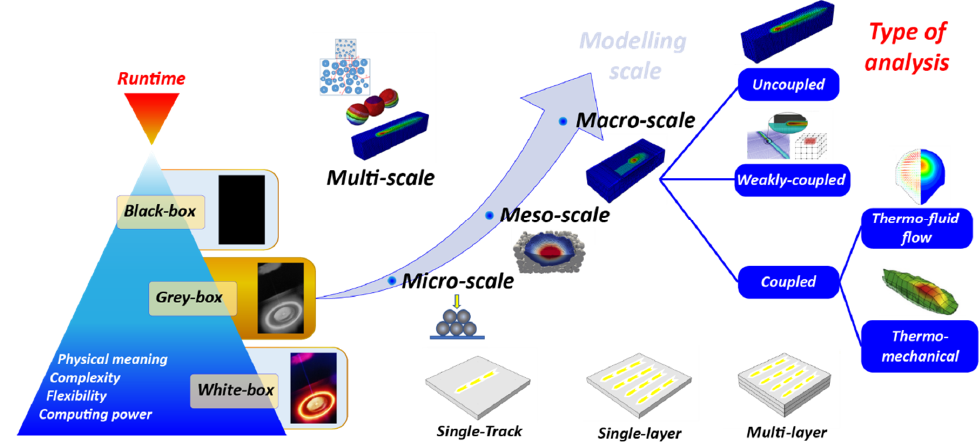
Figure 1. Classification of electron beam melting (EBM) process simulation models.